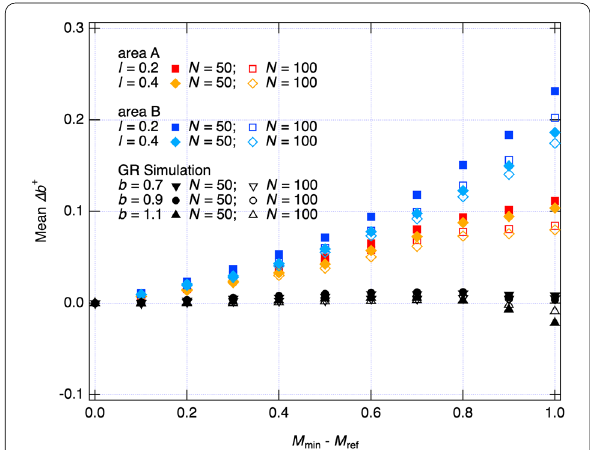
Fig. 8 The difference between the mean of b + estimated using an M min and the mean of b + when M min earthquake with M ≥ The results expected from the GR law for constant values of b are also shown